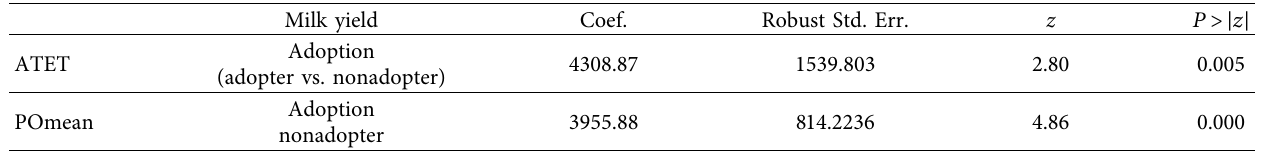
Table 10: Estimation of regression adjustment for milk yield (lit/annum).